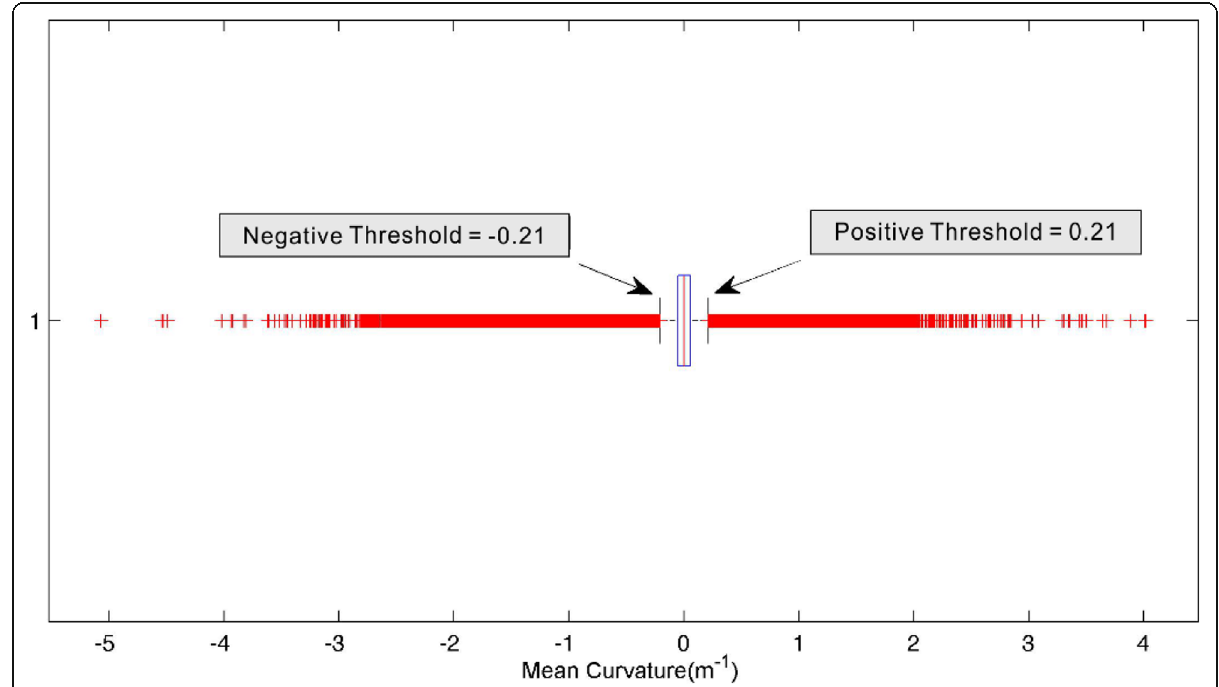
Fig. 11 The boxplot of mean curvature and the negative/positive threshold in the floodplain